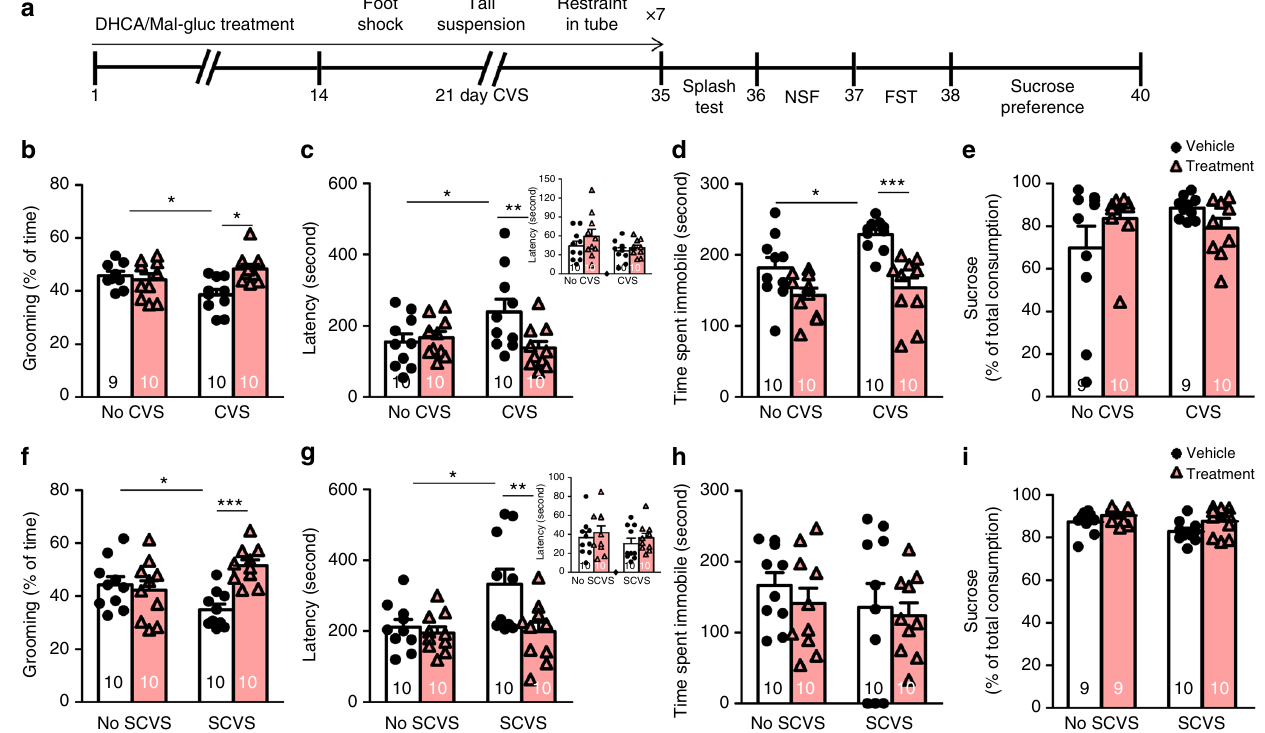
Fig. 6 Prophylactic treatment with DHCA/Mal-gluc attenuates variable stress-mediated depression and anxiety phenotypes in both male and female mice. a Schematic design of the experiment. b – e Behavioral responses of male mice following 21 days of CVS. b Splash test (one-way ANOVA, F 3,38 = 4.61, P = 0.008). c NSF test (one-way ANOVA, F 3,39 = 3.23, P = 0.034). d FST (one-way ANOVA, F 3,39 = 10.30, P < 0.0001) and e sucrose preference test (one- way ANOVA, F 3,37 = 1.65, P = 0.197). f – i Behavioral responses of female mice following 6 days of SCVS. f Splash test (one-way ANOVA, F 3,39 = 5.33, P = 0.004). g NSF test (one-way ANOVA, F 3,39 = 5.22, P = 0.004); h FST (one-way ANOVA, F 3,39 = 0.581, P = 0.631) and i sucrose preference test (one-way ANOVA, F 3,37 = 3.312, P = 0.032). All graphs represent mean ± s.e.m., * P < 0.05, ** P < 0.01, *** P <